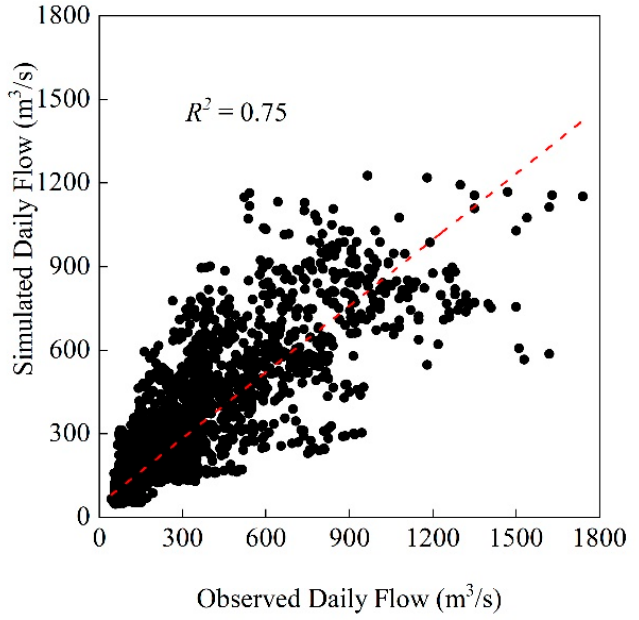
Figure 5. The scatter plots between observed and simulated flow at the TANGJIA station. The red line in the figure represents the fitting curve of measured runoff and simulated runoff. Table 3. Calibrated SPHY model parameter values used for the simulation.